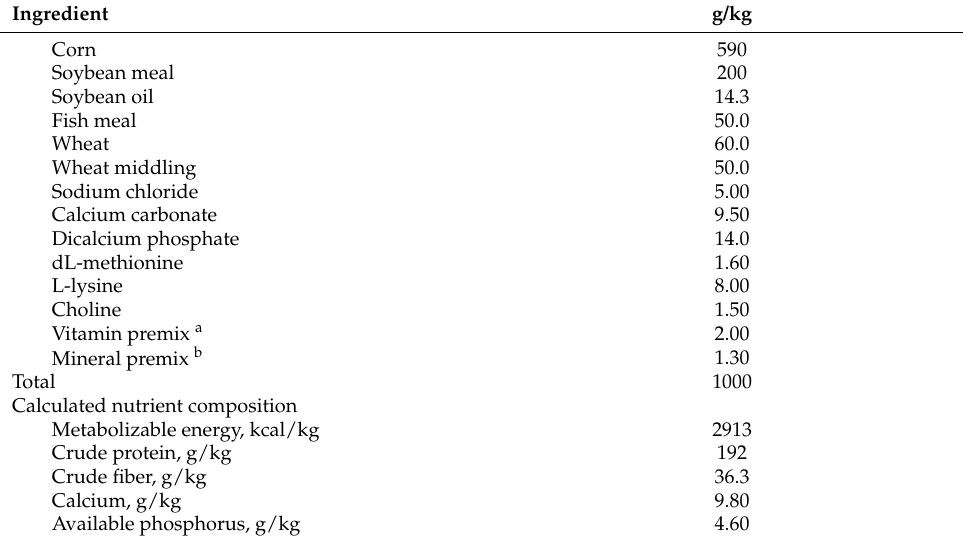
Table 2. Ingredients and nutrient compositions of the basal diet (as fed